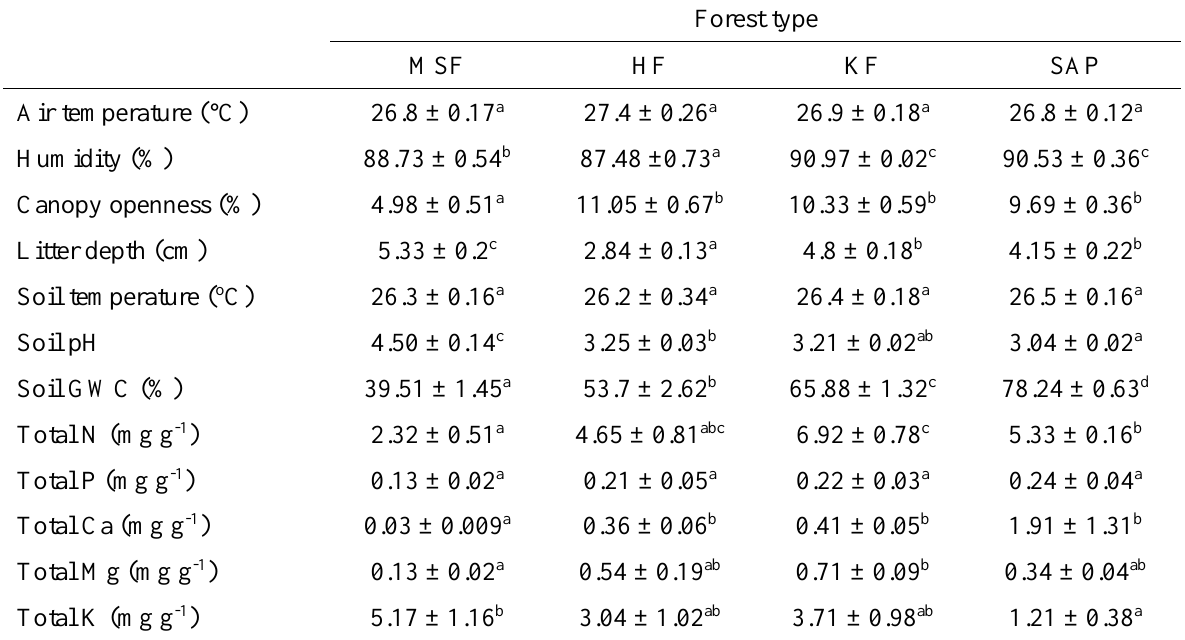
Table 1. Differences in mean values of environmental and soil properties in mixed swamp forest (MSF), heath forest (HF), kerapah forest (KF) and Shorea albida peat-swamp forest (SAP) ( n = 6 plots in HF, KF and SAP, and n = 4 plots in MSF). Values are means ± SE, calculated over the total number of plots per forest type. Same letters along a row represent no significant differences between forest types, while different letters represent significant difference at α = 0.05 as analyzed using one-way ANOVA and Tukey’s HSD